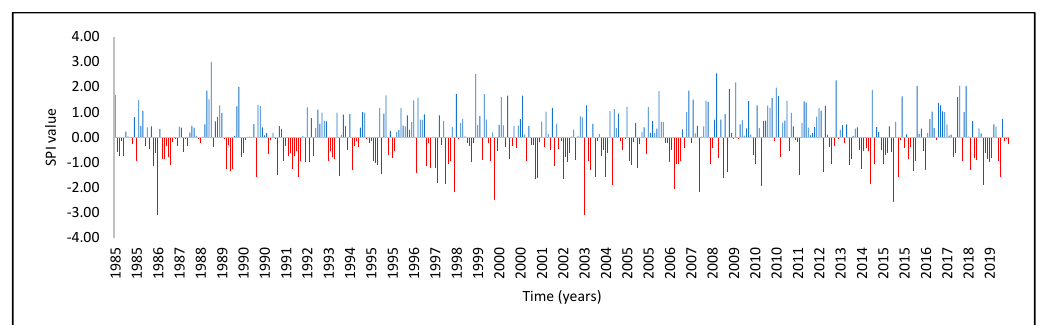
Figure 6. SPI time series, Unisucre station in the period (1985–2019).